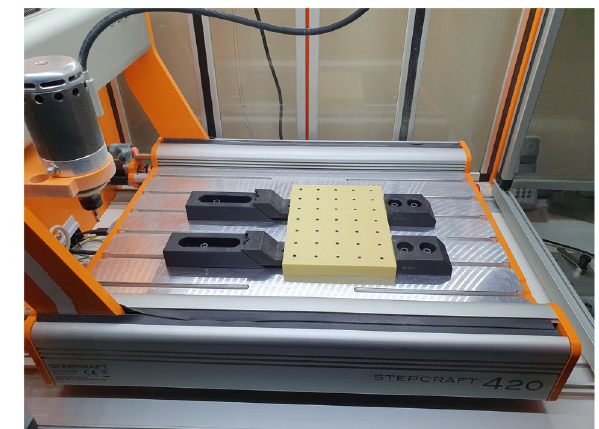
Fig. 2 Implants were placed in Sawbones bone simulation block by Stepcraft 420 computer-aided drilling device (Stepcraft GmbH & Co. KG, Menden, Germany)